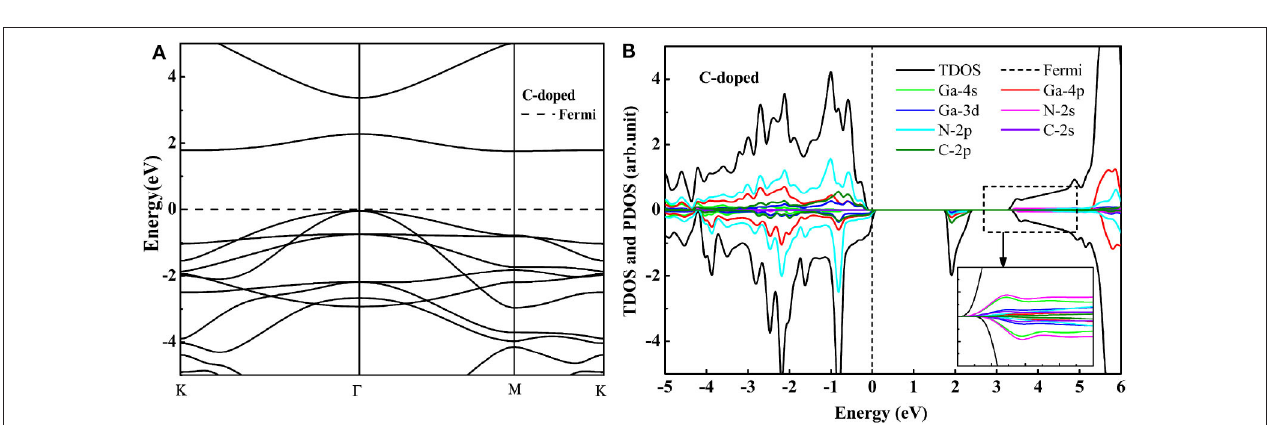
FIGURE 2 | The HSE06 calculated band structure (A) and DOS (B) of the C monodoped GaN nanosheet.